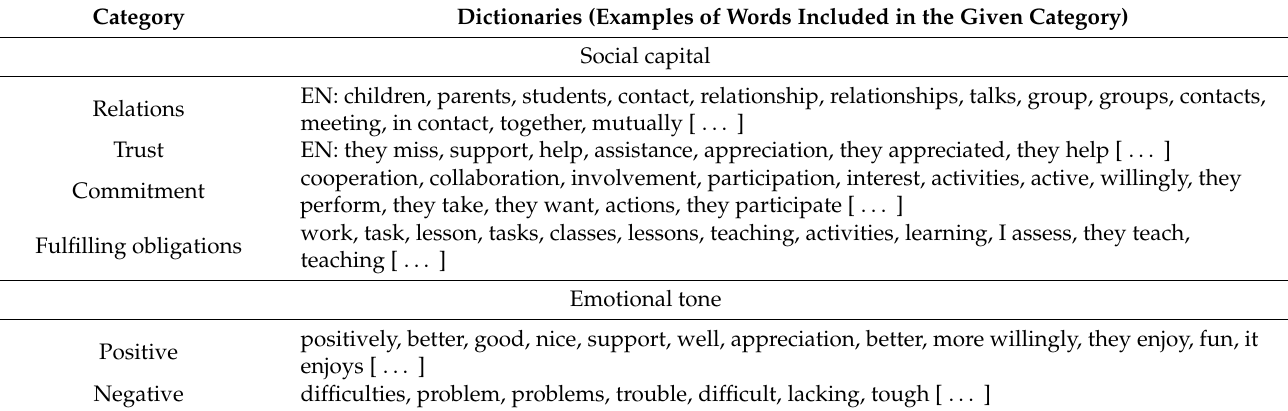
Table 1. Categories of social capital and emotional tone of statements with sample words (indicators). Category Dictionaries (Examples of Words Included in the Given